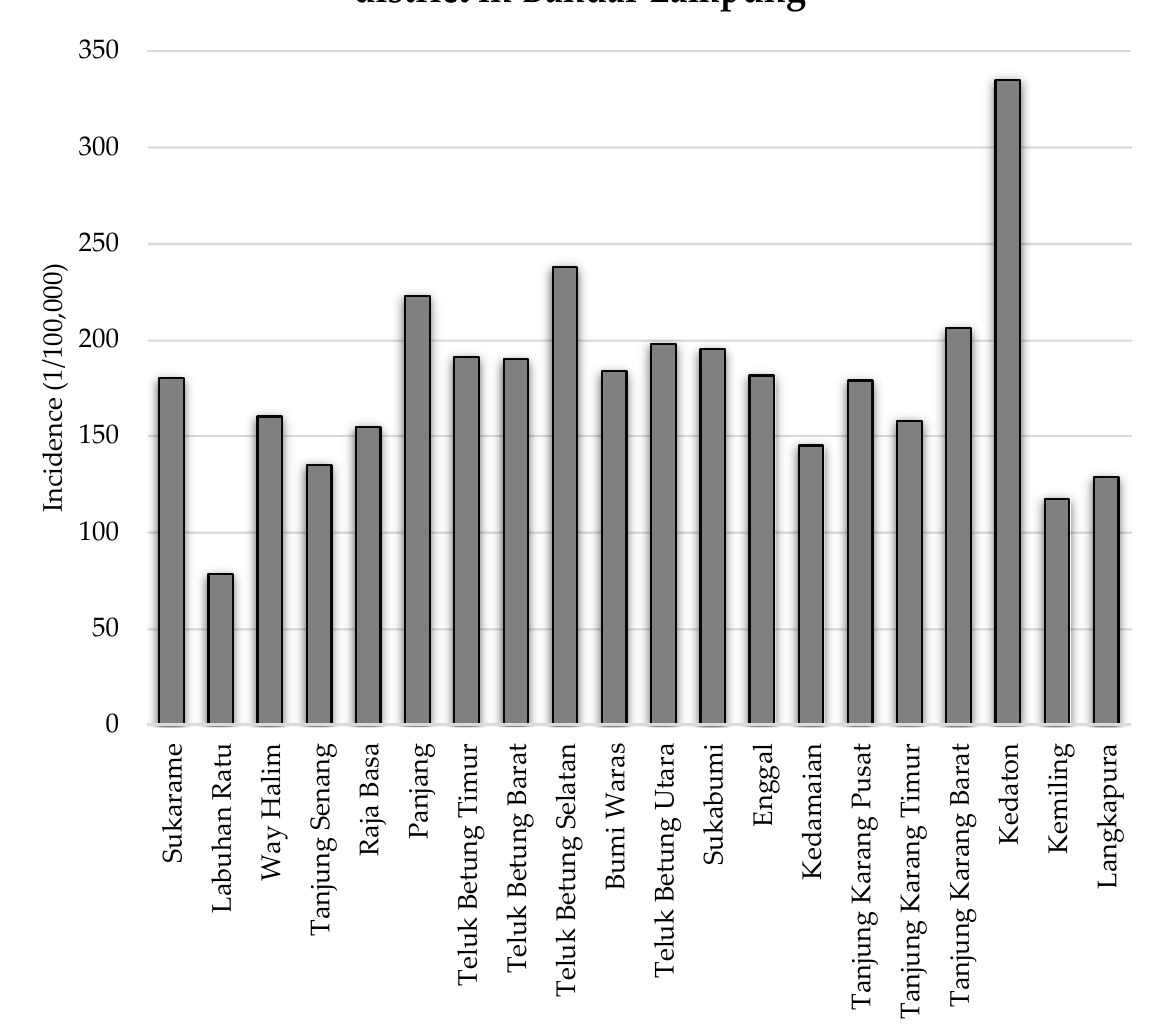
Figure 6. Incidence rate of pulmonary TB in Bandar Lampung in 2020.